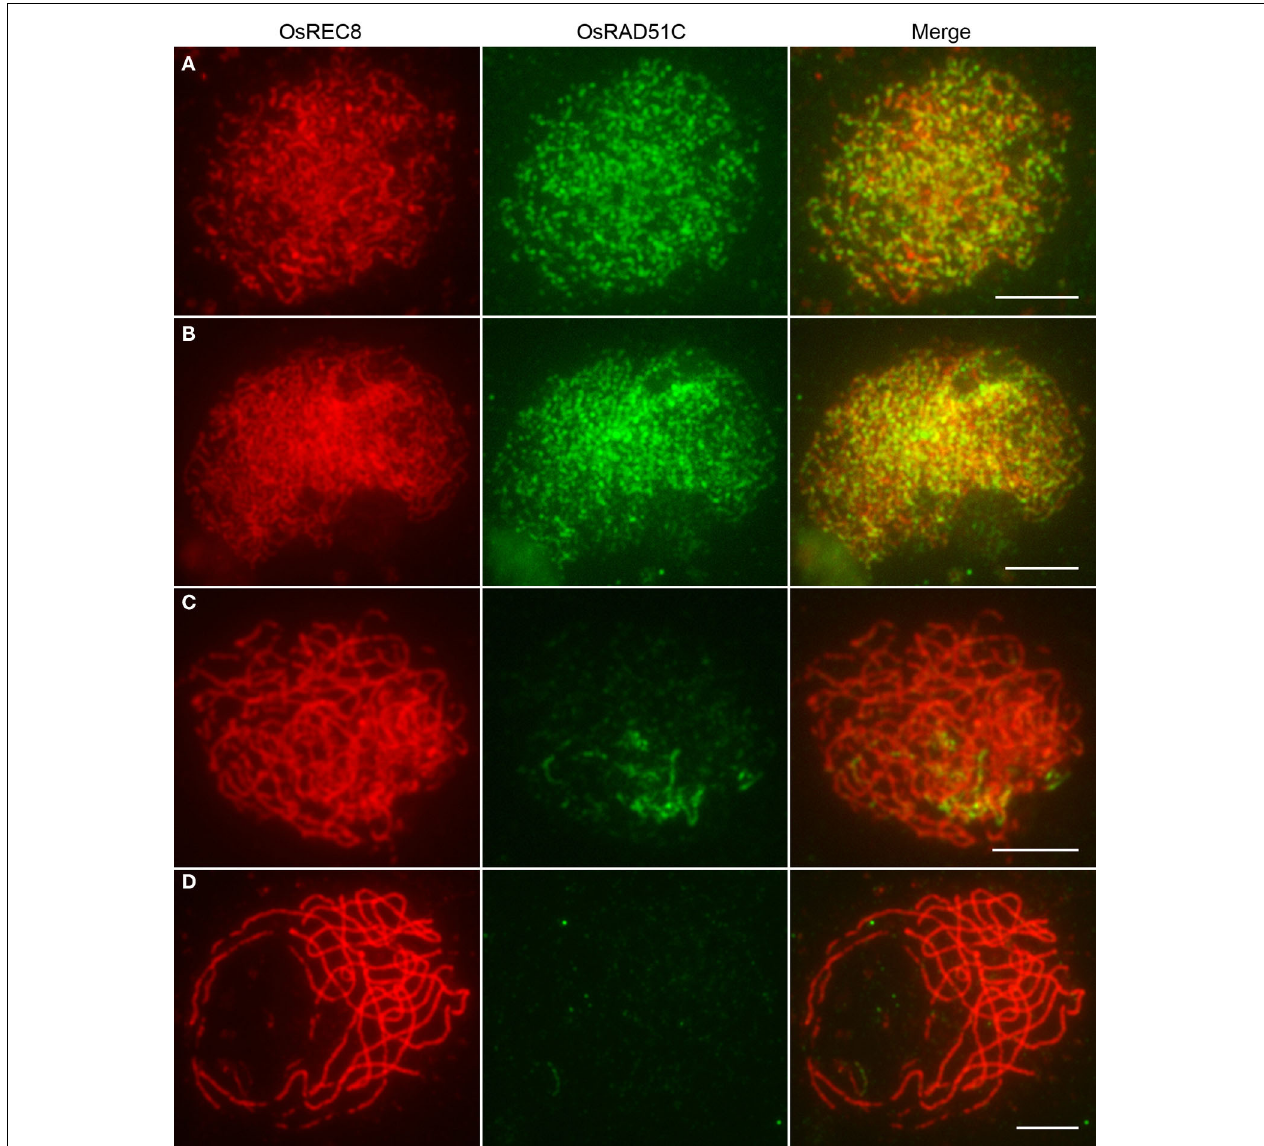
FIGURE 4 | Dual immunolocalization of OsREC8 (red) and OsRAD51C (green) in wild type PMCs. (A) Leptotene; (B) Zygotene; (C) Mid prophase I; (D) Late pachytene. Bars, 5 μ